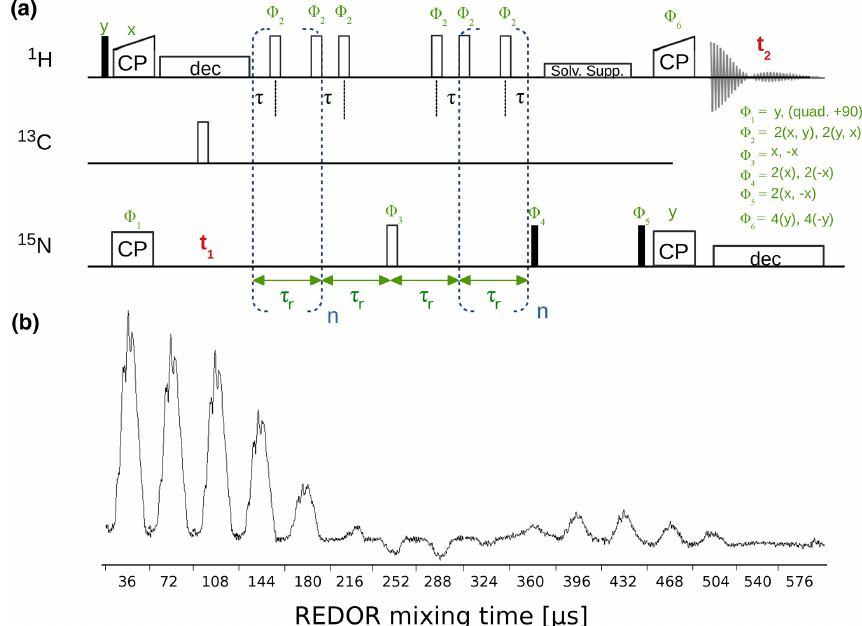
Figure 8. (a) hNH REDOR pulse sequence for measuring dipolar couplings, as implemented in ssNMRlib for 1 H − 15 N (shown here, reported in Haller and Schanda, 2013) and 1 H − 13 C dipolar couplings. Filled and open bars denote π/ 2 and π pulses, respectively. The experiment has the possibility of shifting the central π pulse of each rotor period on the 1 H channel by setting the delay τ (d7), which scales down the dipolar-coupling evolution and therefore allows sampling of the REDOR curve with more points and thus higher precision (Gullion and Schaefer, 1988; Schanda et al., 2010). (b) Experimental series of 1D 1 H − 15 N REDOR spectra, collected at 55.555kHz MAS, 1 H and 15 N π pulses of 5 and 10µs, respectively, and a delay d7 of 3µs (i.e. 0.5µs between the closest consecutive π